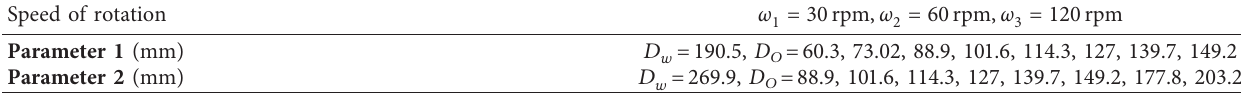
Table 1: Parameters of speed of rotation, well diameter, and drilling tool.